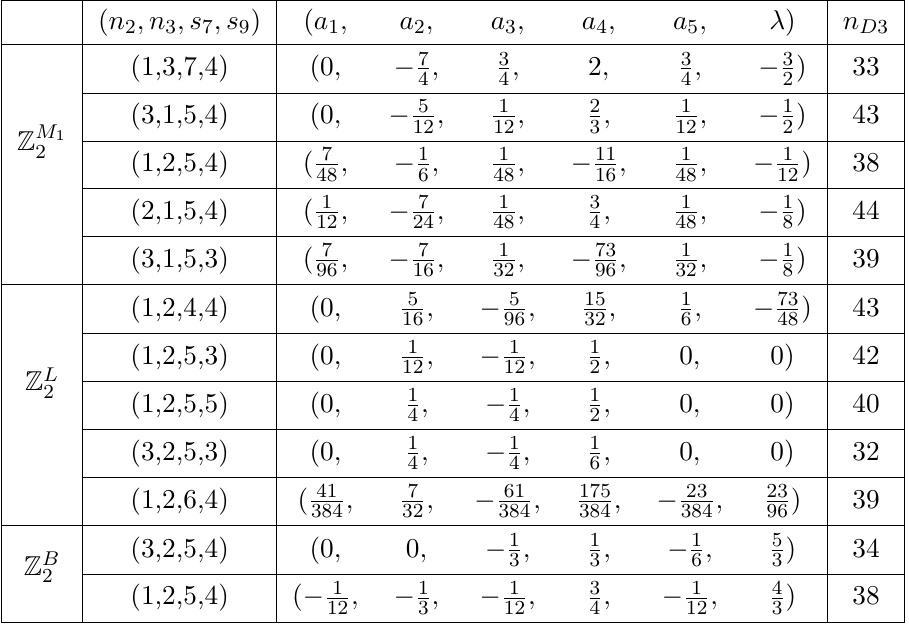
Table 7 . The summary of geometric and (cid:13)ux quanta that lead the three chiral generations for the three discrete symmetry assignments of the second top